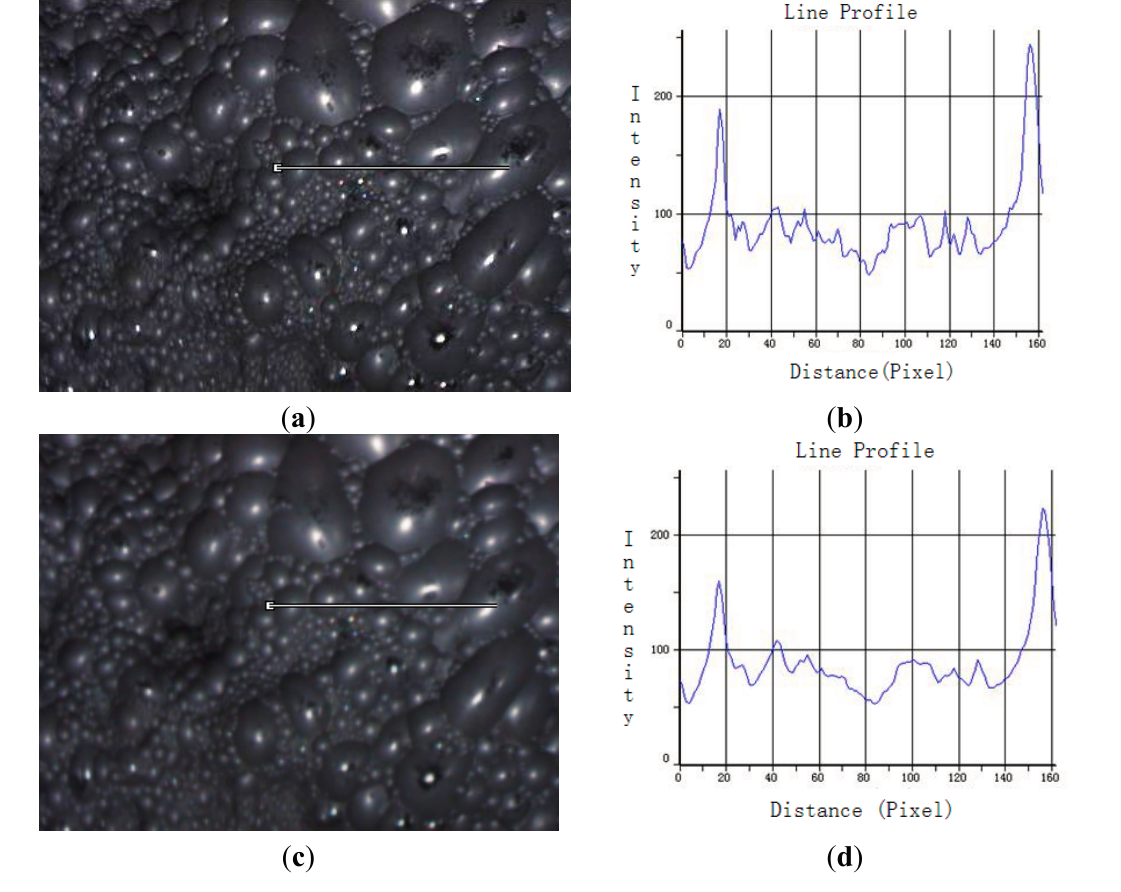
Figure 7. Gray value variance comparison before and after Gaussian filtering. ( a ) Original froth image and a profile line; ( b ) Gray value histogram of the profile corresponding to the image (a) from left to right; ( c ) Result smoothed by the Gaussian filter and profile line at the same position; ( d ) Gray value histogram of the profile corresponding to the image (c) from left to